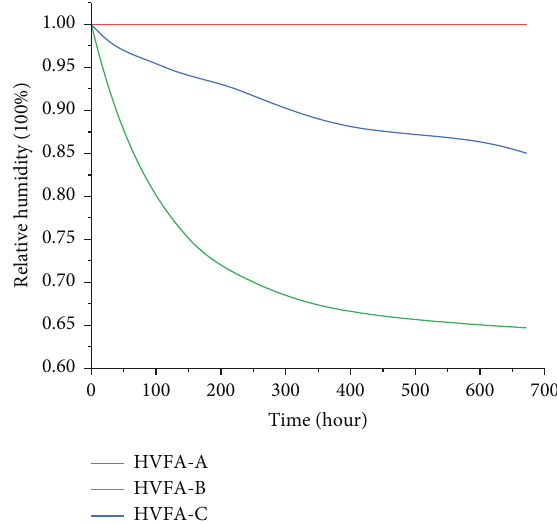
Figure 9: Relative humidity development with time.